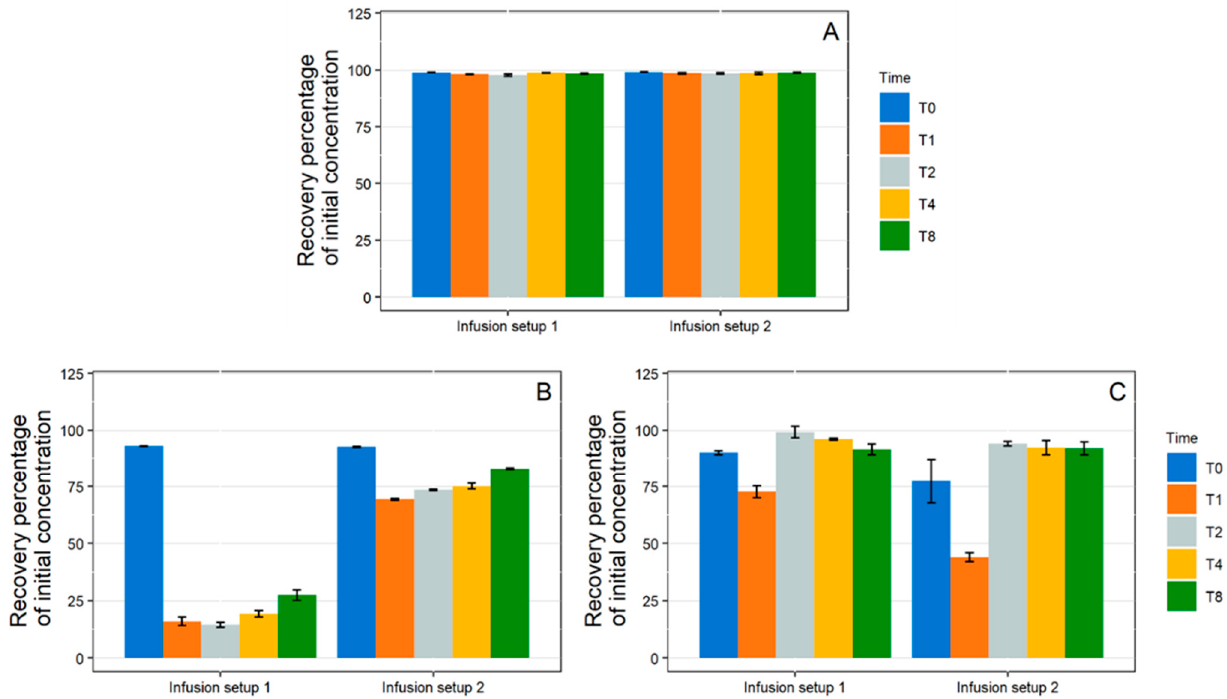
Figure 7. Evolution of the recovered percentage of initial concentration in paracetamol ( A ), diazepam ( B ), and insulin ( C ) in 10 mL/h dynamic condition with both complete infusion setup (setup 1: polypropylene syringe + polyvinyl chloride extension set + Turbo-Flo polyurethane catheter. Setup 2: polypropylene syringe + polyethylene coextruded with polyvinyl chloride extension set + Turbo-Flo polyurethane catheter ( n = 3, mean ± standard error of the mean). T0–T8: different analysis times: immediately after purging (T0), then after 1 h (T1), 2 h (T2), 4 h (T4), and 8 h (T8) of infusion.